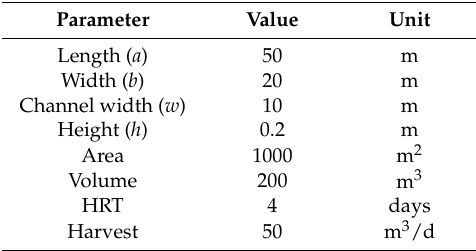
Table 1. Open raceway pond parameters for the pilot plant at Minamisoma.